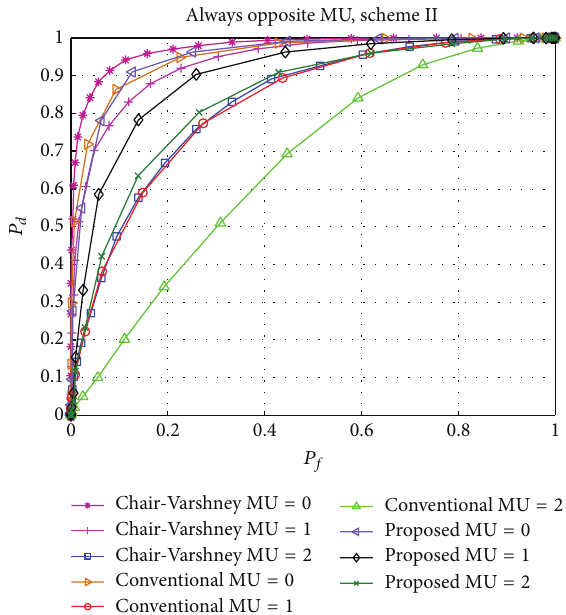
Figure 5: Performance comparison of the Chair-Varshney, conven-